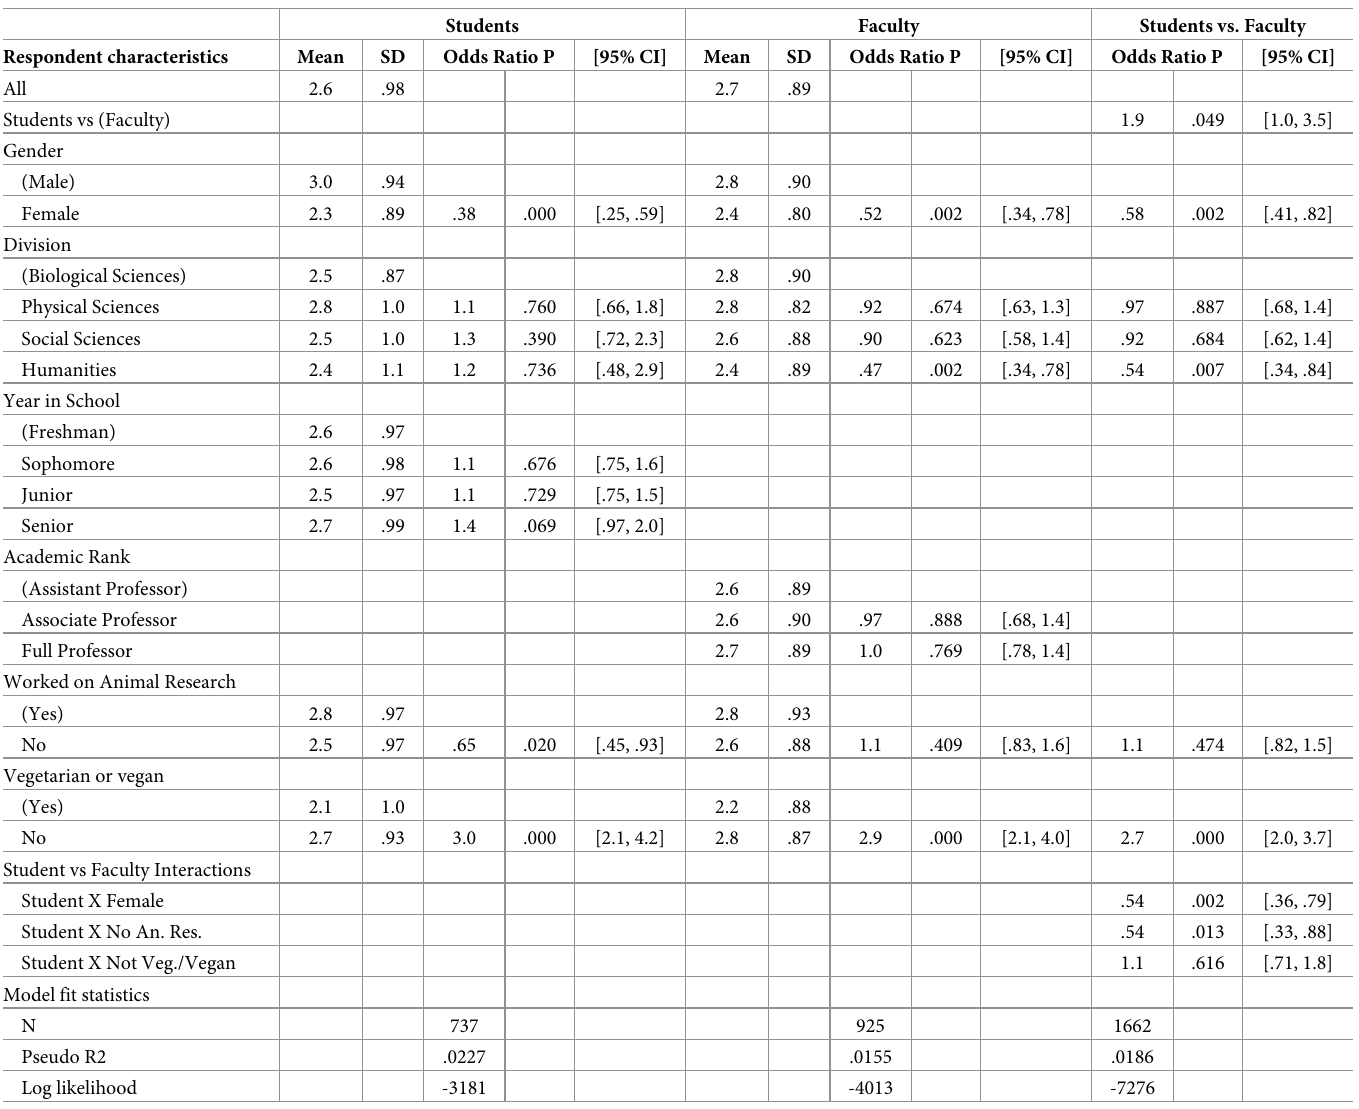
Table 7. ARAS-composite PD scale